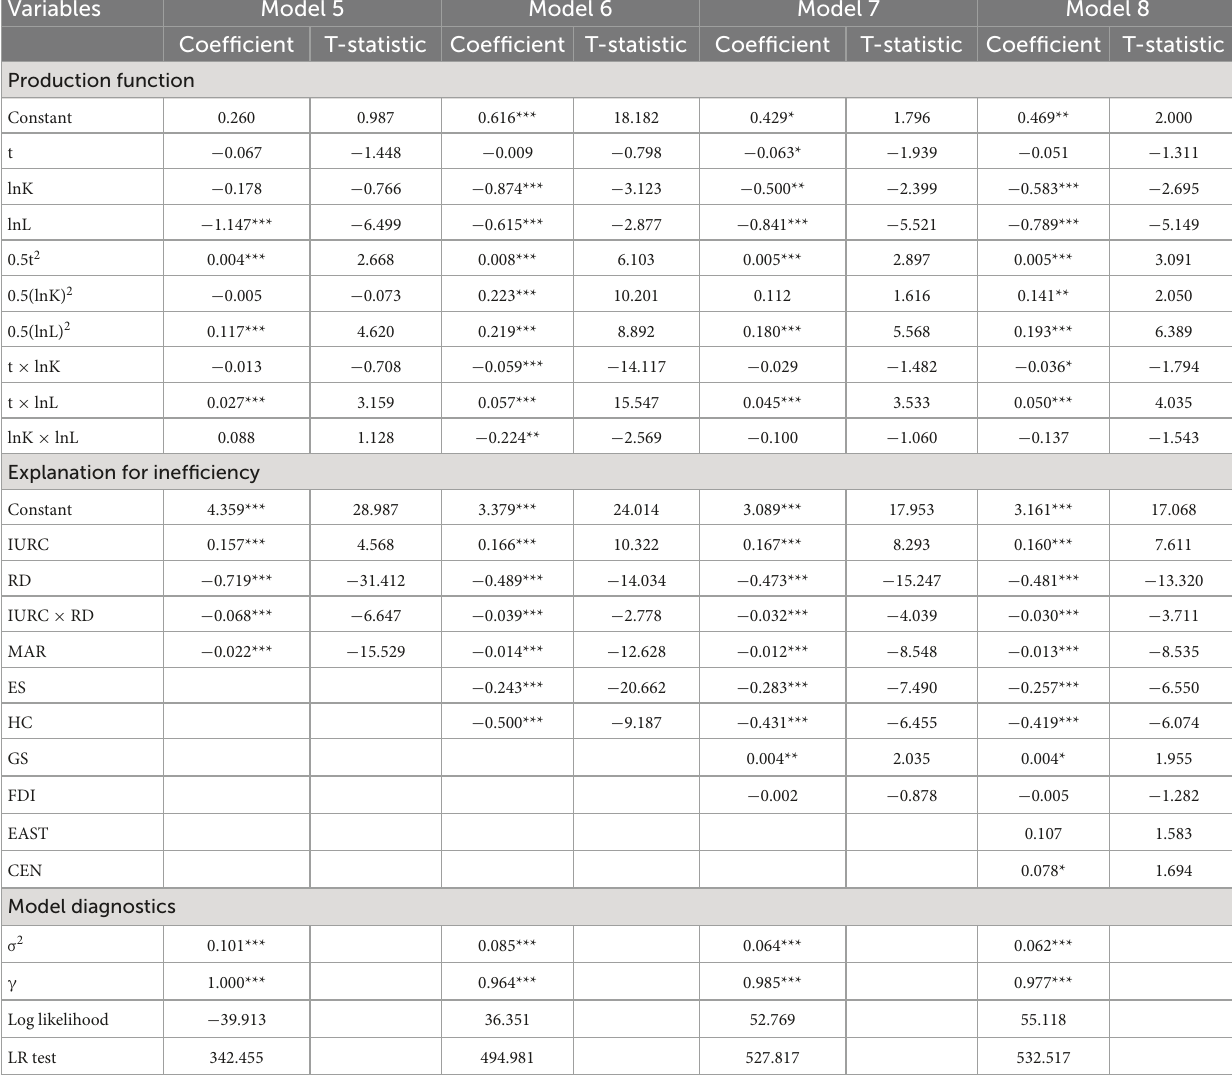
TABLE 7 Estimates of the dual effects of